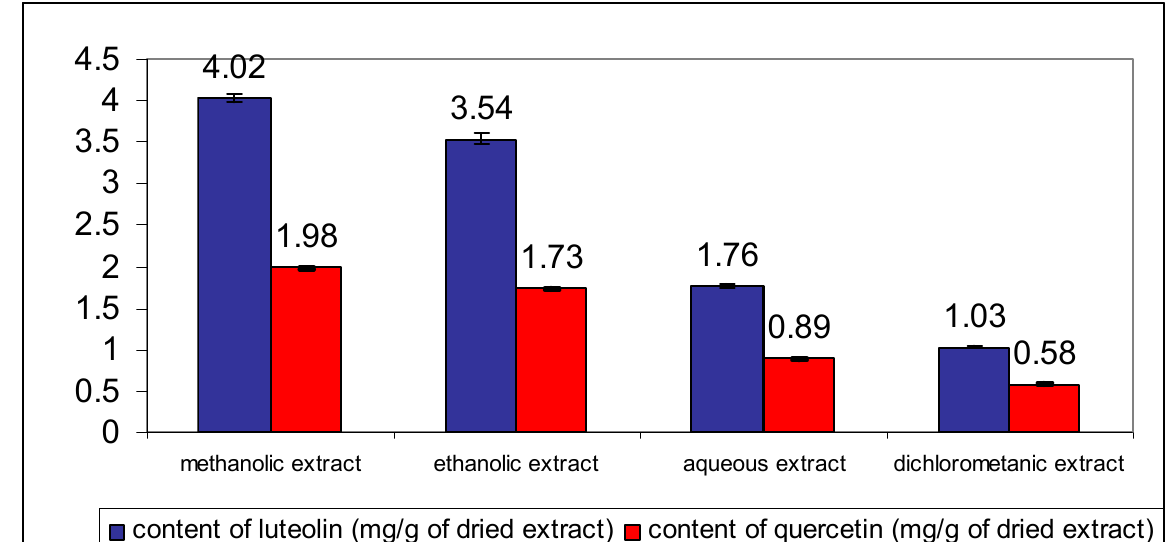
Figure 3. Contents of luteolin and quercetin in different C. platycarpos extracts. Each value is the mean ± standard deviation of six independent